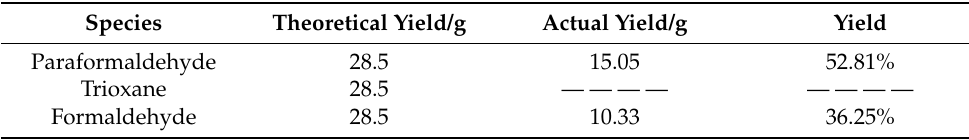
Table 2. The product yield with different aldehydes. Species Theoretical Yield/g Actual Yield/g Yield Paraformaldehyde 28.5 15.05 52.81% Trioxane 28.5 — — — — — — — — Formaldehyde 28.5 10.33